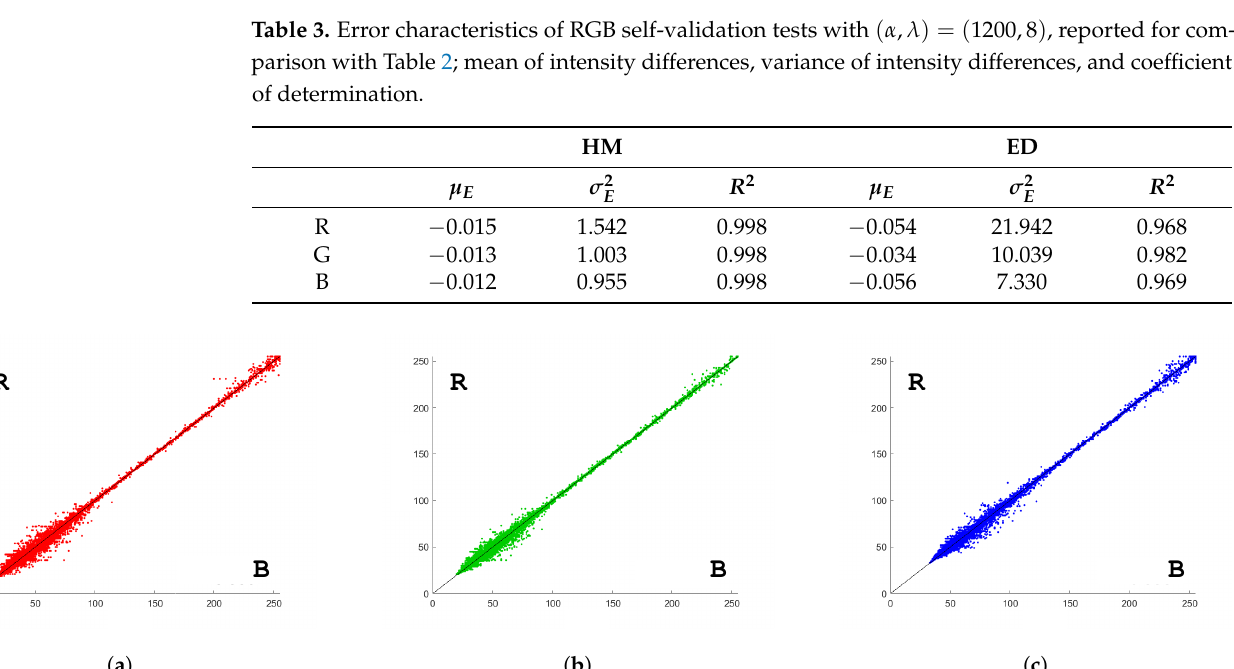
Figure 11. RGB self-validation test—HM based reconstruction; B = Base intensity values, R = Reconstructed intensity values. ( a ) scatter plot of red values; ( b ) scatter plot of green values; ( c ) scatter plot of blue values.